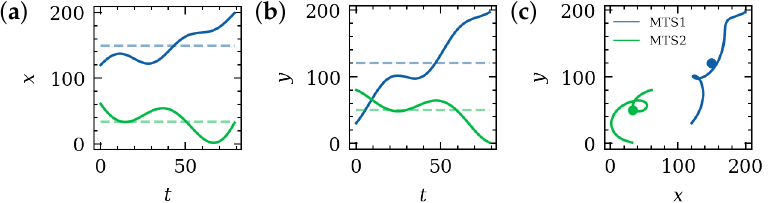
Figure 2. Similarity between two-dimensional time series by the distance between centroids of the corresponding spatial objects in the two-dimensional space. ( a ) Mean value of time series in dimension x ; ( b ) Mean value of time series in dimension y ; ( c ) Euclidean distance between the centroids of the corresponding spatial objects.